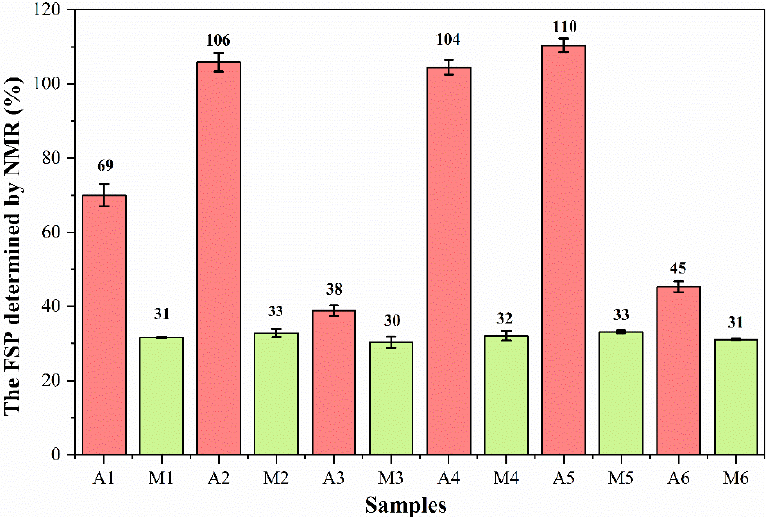
Figure 6. The nuclear magnetic resonance (NMR) determined fiber saturation point (FSP) of water- logged archaeological wood samples (A1–6) and modern wood samples (M1–6).